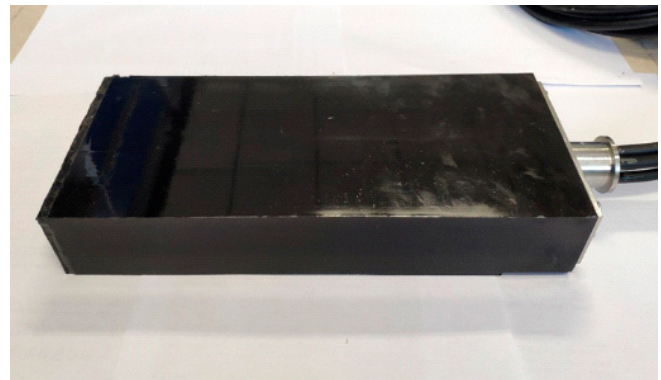
Figure 9. Physical pictures of the transducer array.